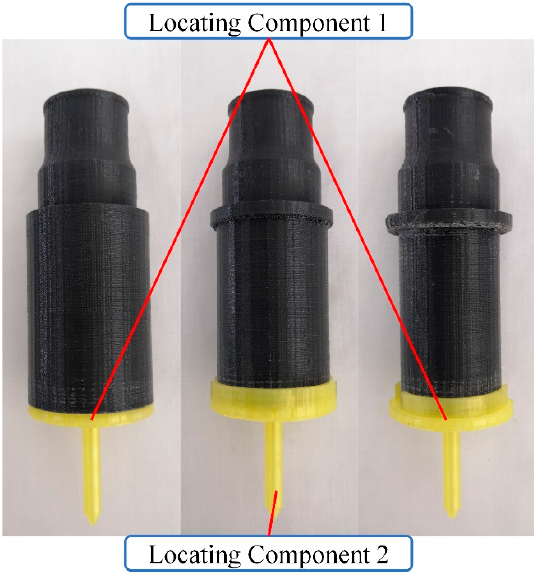
Figure 12. Assembly diagram of locating components.